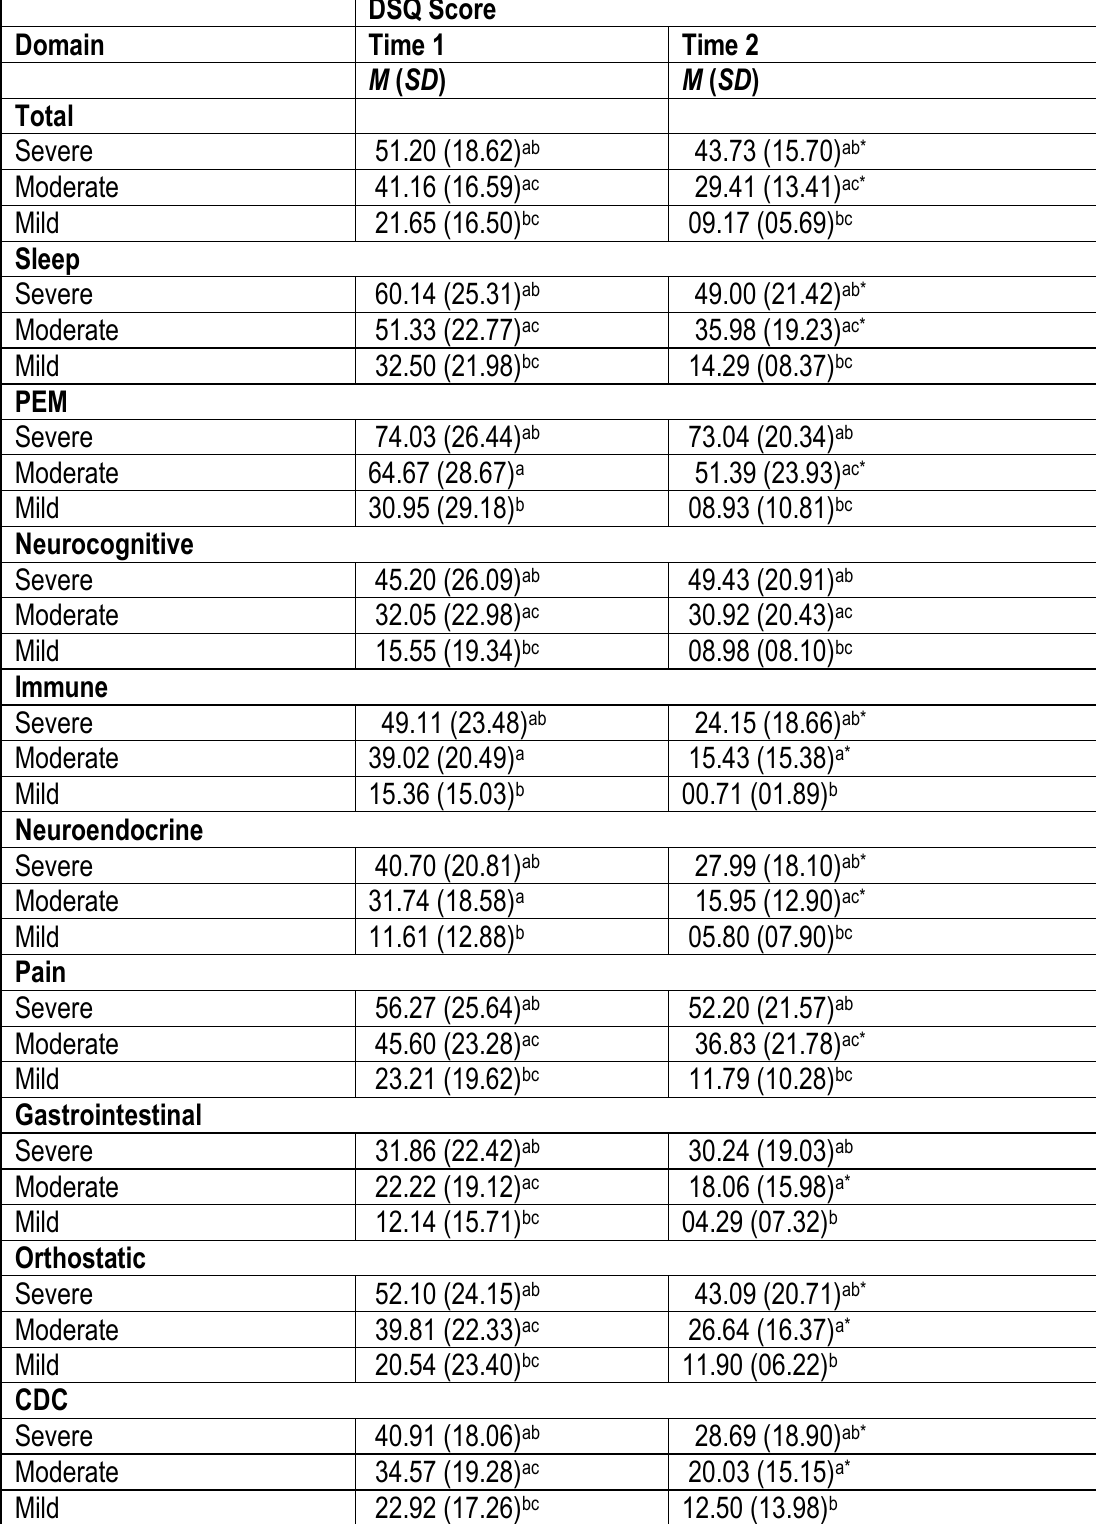
Table 3. Descriptive and inferential statistics for DSQ scores across symptom domains and